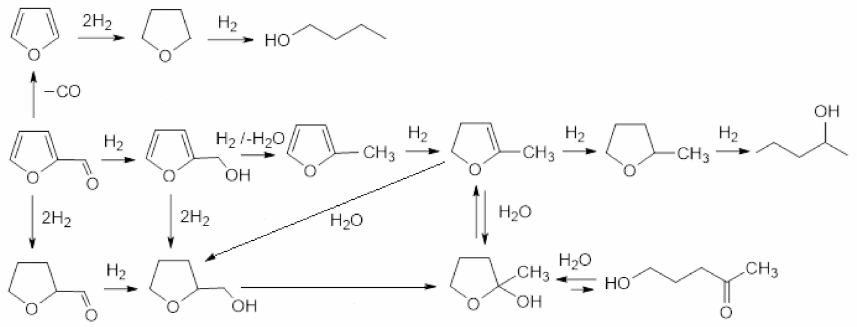
Figure 5. Main products of furfural reduction on metal catalysts in the water phase